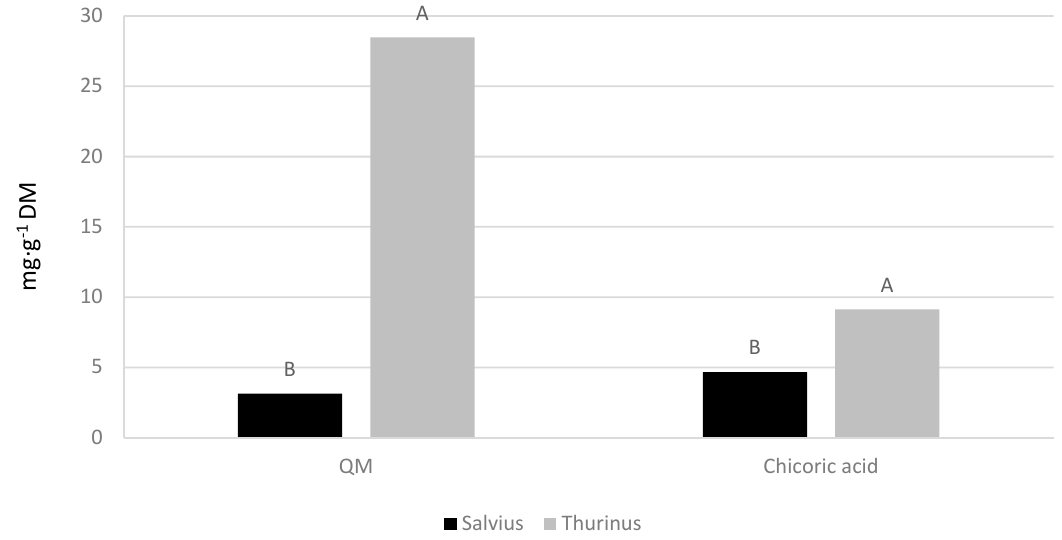
Figure 3. Effect on quercetin-malonyl (QM) and chicoric acid concentrations in leaf tissue of ‘Salvius’ and ‘Thurinus’, red and green romaine lettuce cultivars, respectively. Values followed by the same letter are not significantly different at p ≤ 0.05 according to the Tukey’s Honest Significant Difference test.